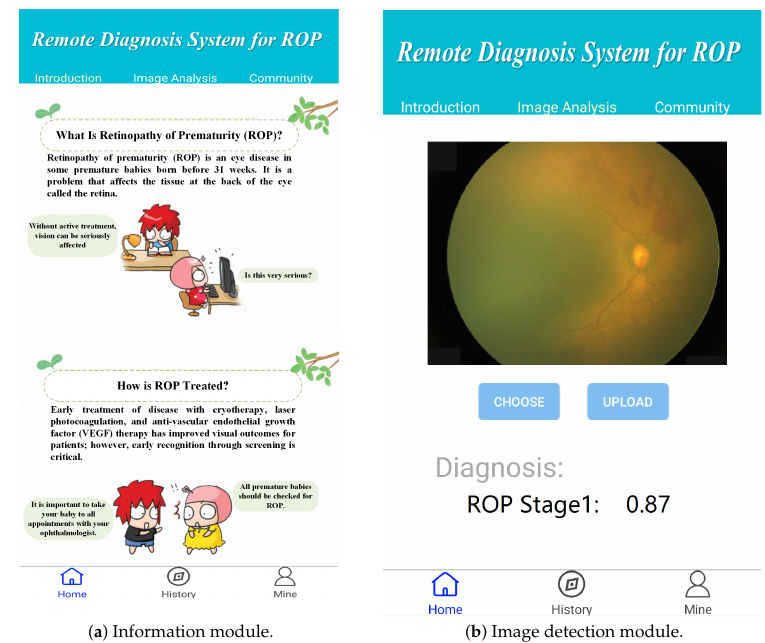
Figure 6. Mobile application interface for the Android